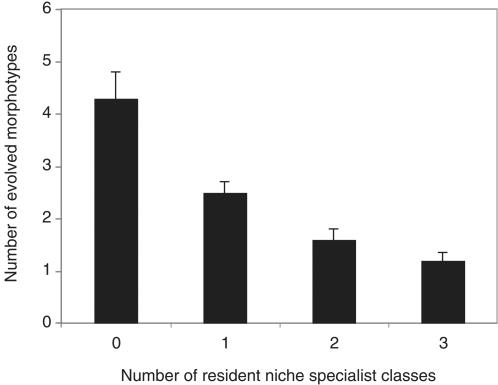
Diversification of an initially rare invading lineage as a function of the number of resident niche specialists. Bars show mean (+SEM) number of novel morphologically distinct morphotypes; this value does not include the invading ancestral genotype.